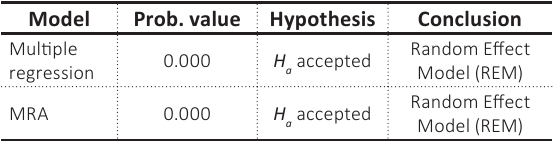
Table 4. Lagrange multiplier test results